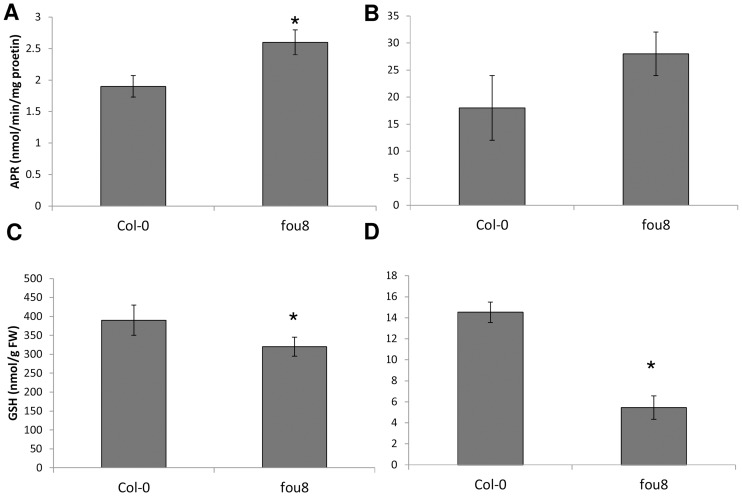
Accumulation of sulfur-containing compounds in fou8.Col-0 and fou8 plants were grown for 5 weeks in controlled environment room. Leaves were harvested and A APR activity was determined. Levels of B cysteine C glutathione, and D sulfate were measured by HPLC. Results are presented as means ± SE from six individual plants, grown in two independent experiments. Asterisks mark values significantly different from Col-0 at P<0.05.